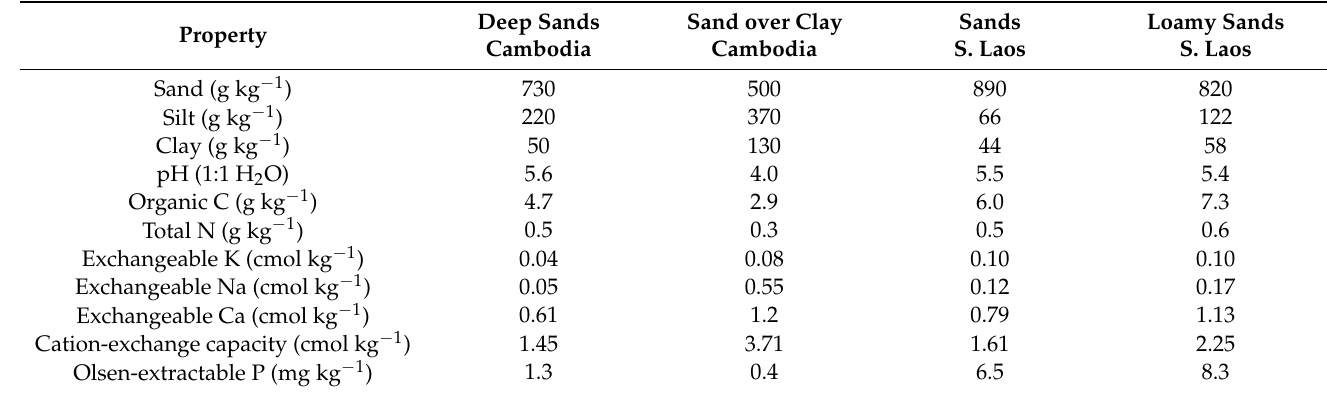
Table 1. Chemical properties of surface layers (0–20 cm) of typical sands of Cambodia and Southern Laos. In Cambodia, the soils are from the Prey Khmer Soil Group (deep sand) and Prateah Lang Soil Group (sand over clay) [12] of rice soils. For Southern Laos, the values are means from [13]: sands at <500 mm elevation cover 0.09 million hectares while loamy sands cover 1.17 million hectares. (Data sources: